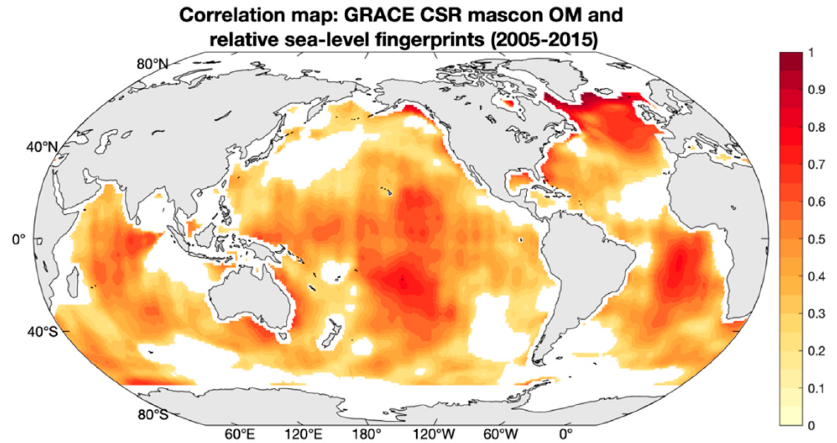
Figure 10. Pearson’s correlation map between GRACE ocean mass (OM) and relative sea-level fingerprints time series for January 2005–December 2015. The map only shows positive correlations that are statistically significant at 95% confidence level.